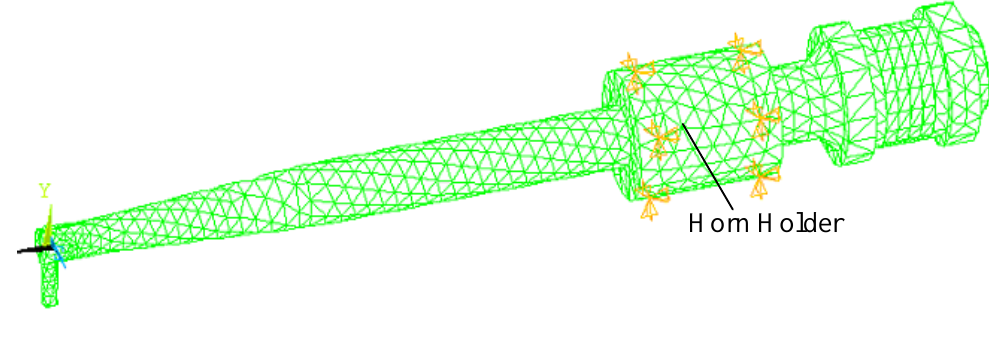
Figure 7. The transducer model with holder constrained by eight points.